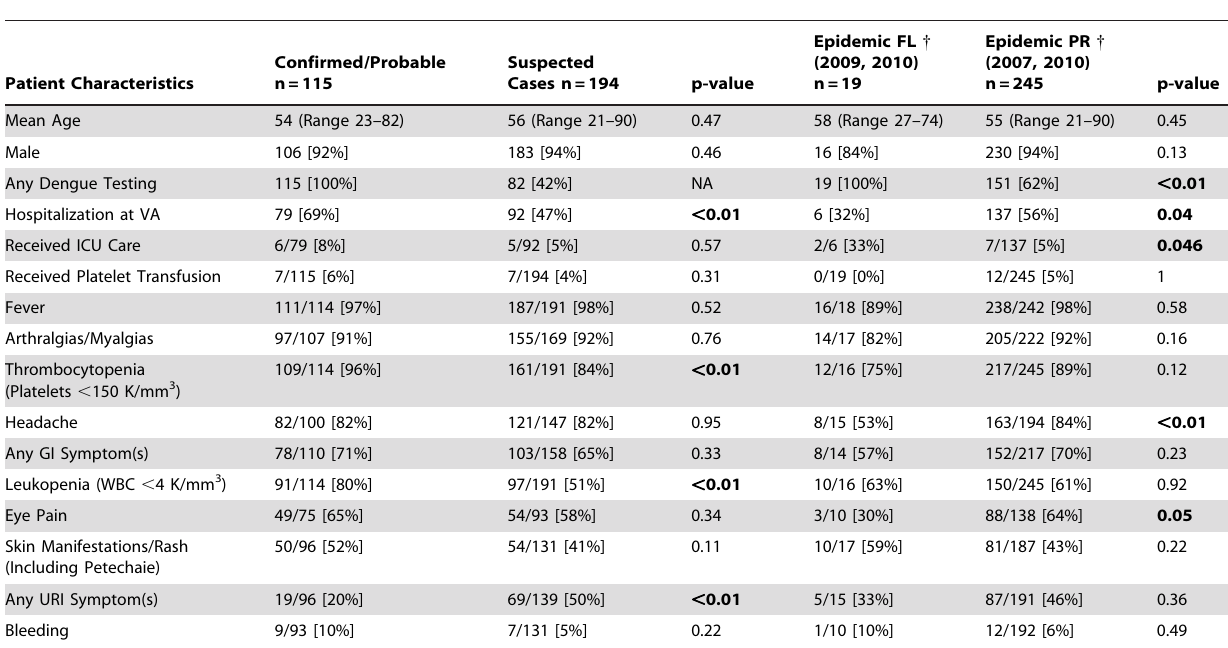
Table 2. Patient characteristics of confirmed/probable versus suspected dengue cases and epidemic cases in Florida and Puerto Rico veterans affairs facilities,